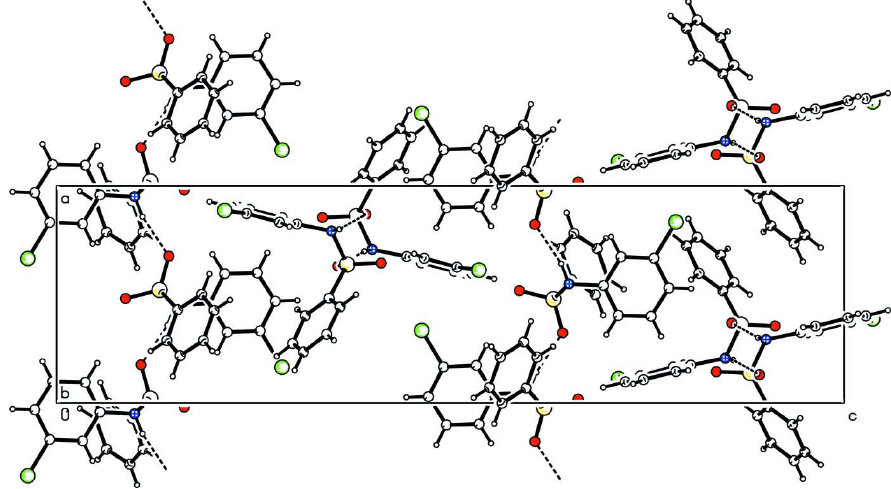
Figure 2 Molecular packing of the title compound, showing hydrogen-bonded (dashed lines) chains. N -(3-Chlorophenyl)benzenesulfonamide Crystal